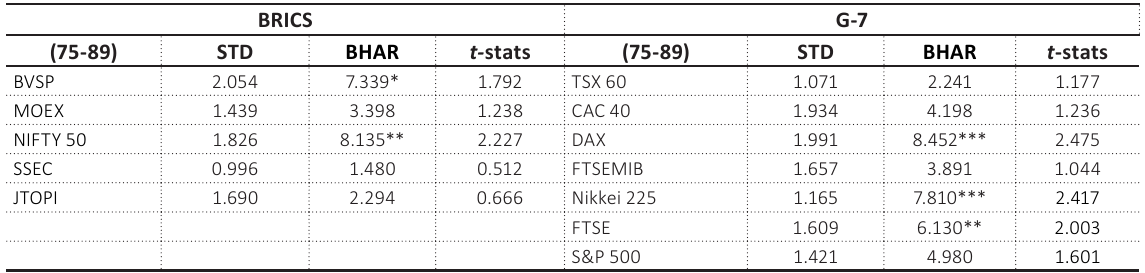
Table 8. BHAR in the event window (75-89) for G-7 and